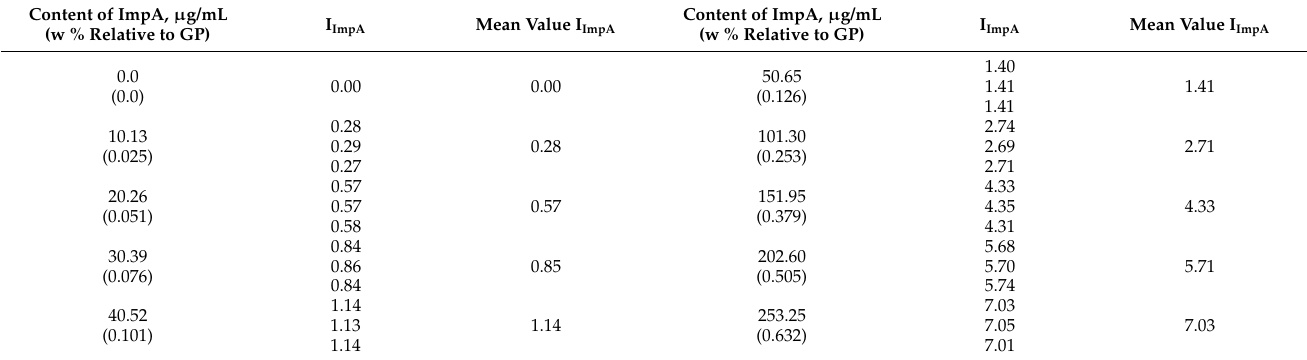
Table 1. Results of the linearity evaluating of the validated method. Content of ImpA, µ g/mL (w % Relative to